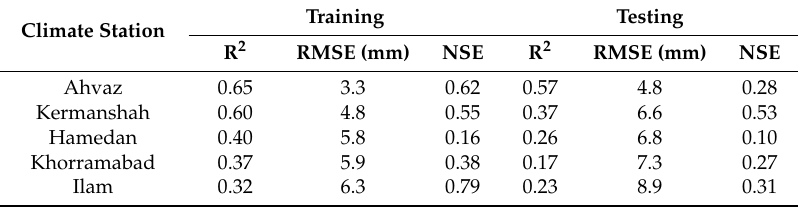
Figure 4. Observed and NARX model-predicted daily rainfall for the KRB stations for training and testing stages. Table 5. Coefficient of determination (R 2 ), root-mean-square error (RMSE) and Nash–Sutcliffe efficiency (NSE) of the NARX-model fits for the 5 KRB climate stations for the training and testing phases.